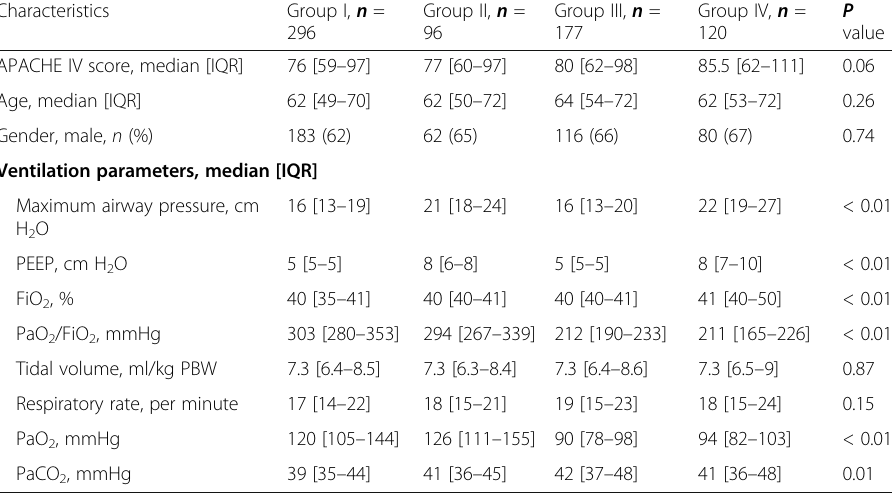
Table 2 Main characteristics of patients with hypoxemia classified 24 h after onset of hypoxemia